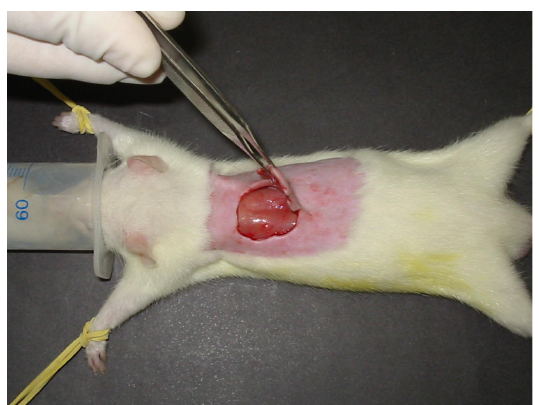
FIGURA 3 - Excisão da pele. Nota: Observar o detalhe da área demarcada pelo punch e seccionada respeitando-se o plano